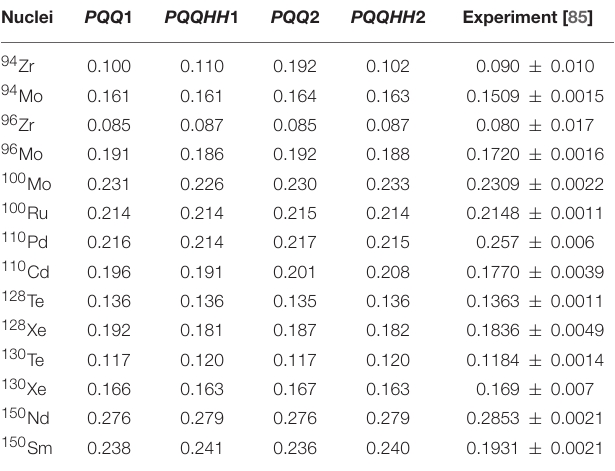
TABLE 1 | Theoretically calculated deformation parameters β 2 of nuclei participating in ββ decay with PQQ 1, PQQ 2, PQQHH 1, and PQQHH 2 parametrizations of effective two-body interaction along with experimental recommended values [85]. Nuclei